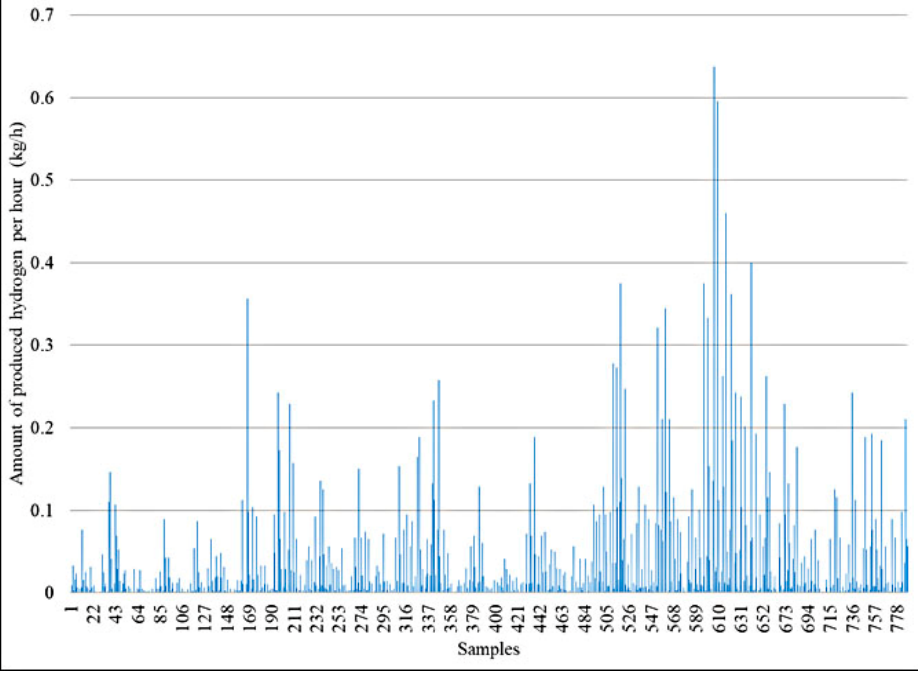
Figure 13. The amount of hydrogen produced based on each test sample.